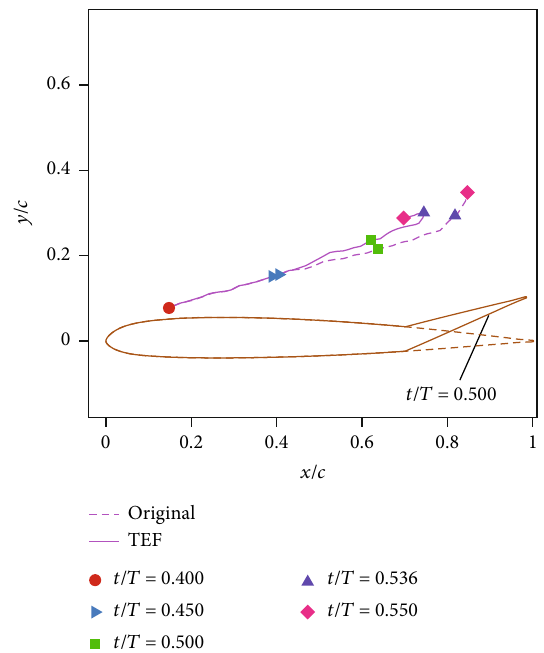
Figure 19: Vortex center trajectories shown in the airfoil coordinate system over the dimensionless time interval 0 : 4 < t / T < 0 : 55 for the two